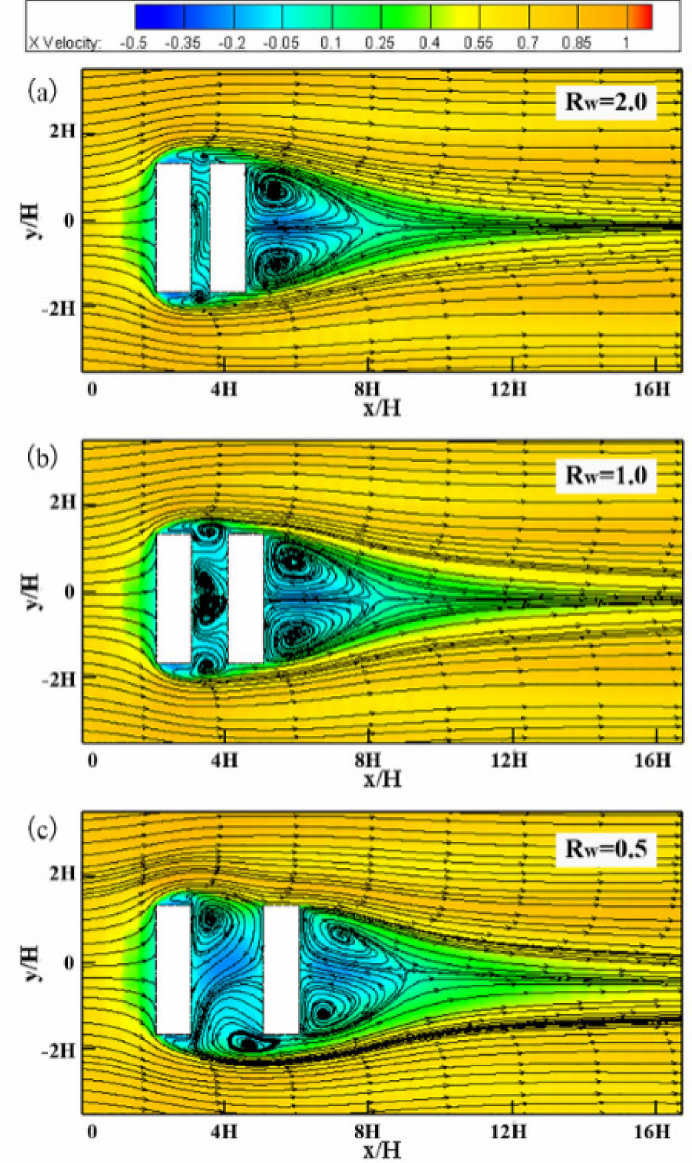
Figure 6. Time-averaged streamlines and flow velocity contours on the horizontal plane (z/H = 0.5) of streets with different aspect ratios: ( a ) R w = 2.0; ( b ) R w = 1.0; ( c ) R w = 0.5. Figure 7 shows the time-averaged streamlines and flow velocity contours of the vertical plane in the middle of street buildings (y = 0) with different aspect ratios. The longitudinal streamlines of the three street canyons are similar, and the vortex centers are close to the top of the downstream buildings. As the street aspect ratio decreases, the vortex shape on the vertical section tends to be complete. The air generally flows in near the windward side of the downstream buildings and flows out near the leeward side of the upstream